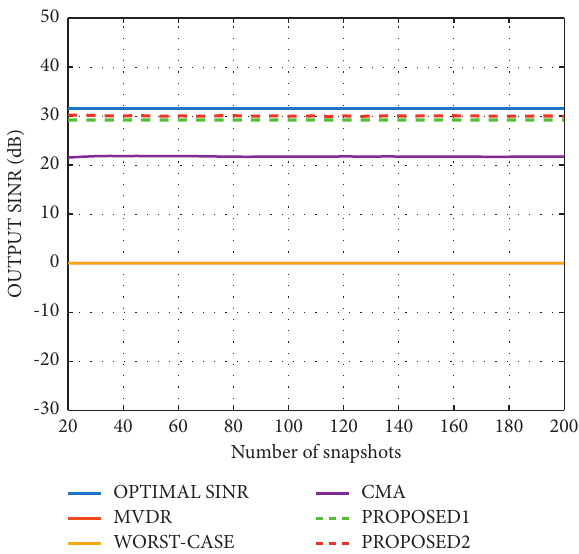
Figure 8: Fixed look direction mismatch: output SINR versus the number of snapshots.